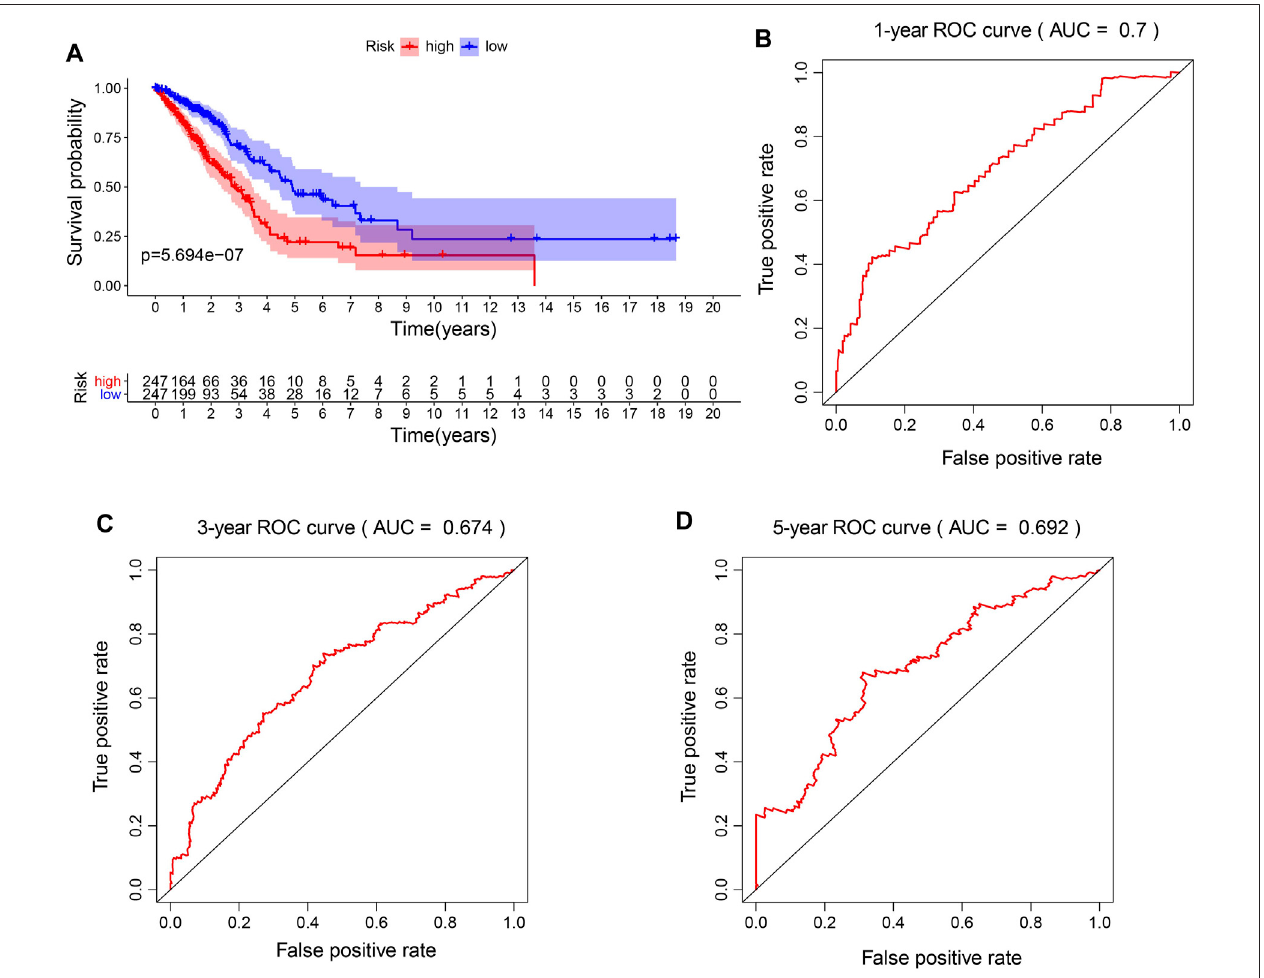
FIGURE 2 | Prognostic accuracy of the risk model. (A) . The survival analysis of high-risk signature and low-risk signature in LUAD patients. (B – D) . The 1-year, 3- year, and 5-year area under the curve (AUC) of ROC curves.